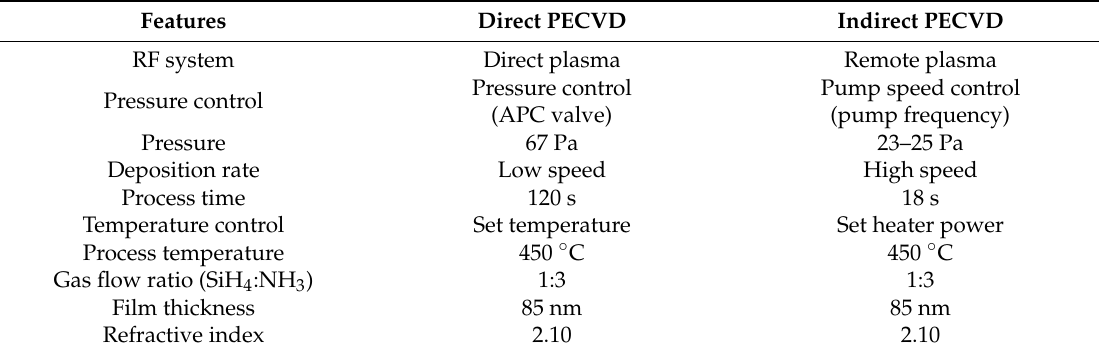
Table 1. The comparison of direct and indirect PECVD and the controlled film thickness and refractive index of